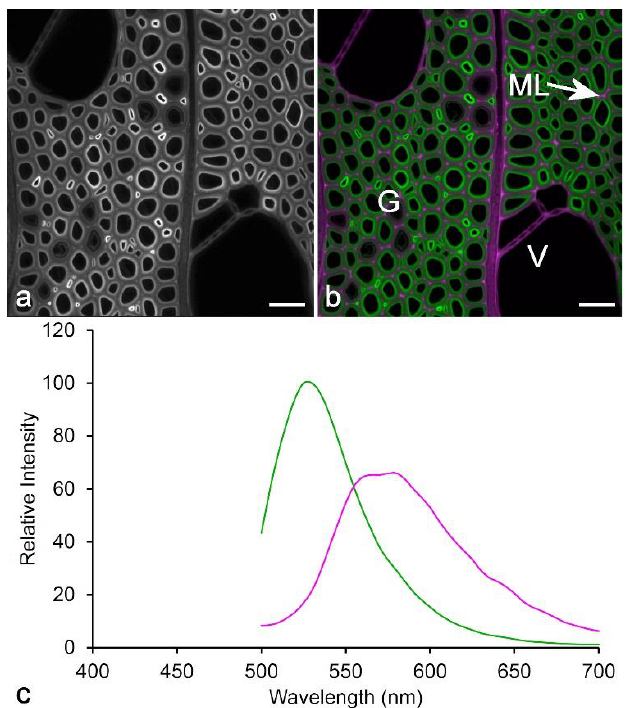
Figure 12. Spectral unmixing using Poisson NMF in ImageJ software [93]. ( a ) Poplar wood showing monochromatic lignin fluorescence (excitation at 488 nm, emission at 500–700 nm). Scale bar = 30 µ m. ( b ) Poplar wood showing two-channel spectral unmixing calculated using Poisson NMF from a spectral image sequence (excitation at 488 nm, emission at 500–700 nm in 5 nm steps). The crimson regions correspond to areas rich in guaiacyl lignin (vessel cell walls [V] and middle lamella [ML]), while the green regions are rich in syringyl lignin (fiber secondary cell walls). The darker fibers (G) are gelatinous fibers (reaction wood) with weakly lignified cell walls. Scale bar = 30 µ m. ( c ) Spectra calculated by blind unmixing using Poisson NMF [32,93]. The use of green and crimson for two-channel overlays is an alternative to green and red to accommodate color-blind readers.